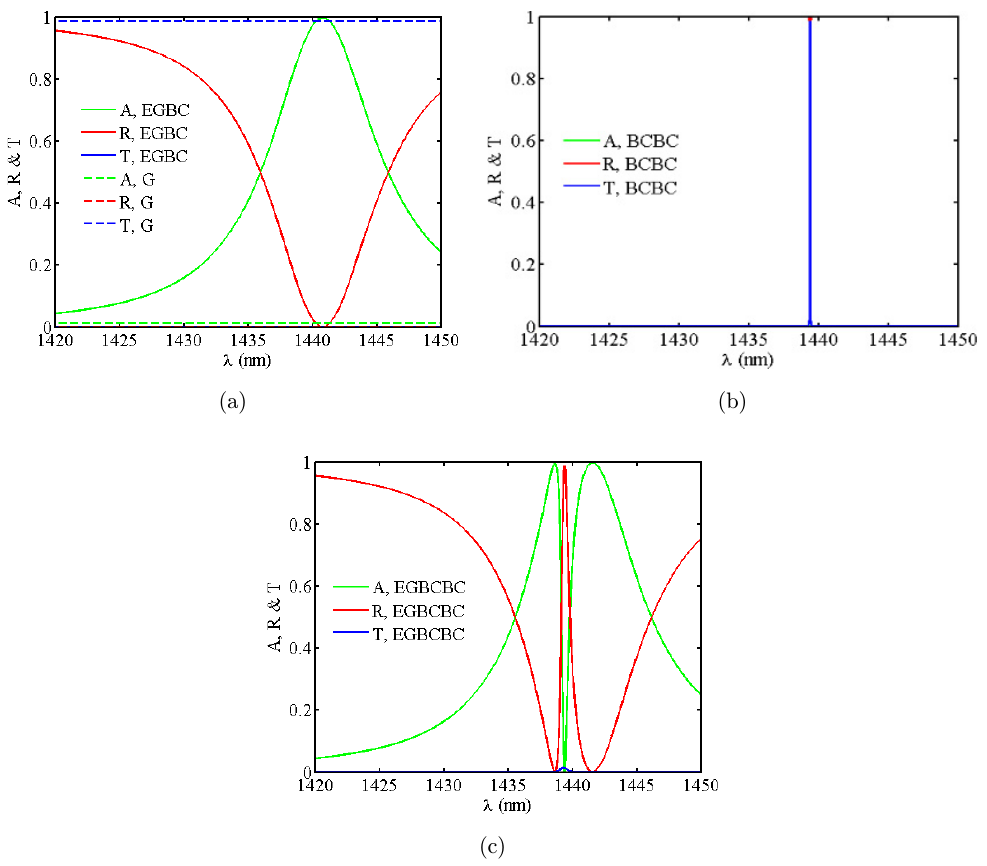
Fig. 2. The absorption ( A ), re°ection ( R ) and transmission ( T ) spectra of the structure (a) EGBC, (b) BCBC, and (c) EG(BC) 2 under TIR, respectively. The absorption ( A ), re°ection ( R ), and transmission ( T ) of graphene monolayer are also plotted in (a) for comparison (dash